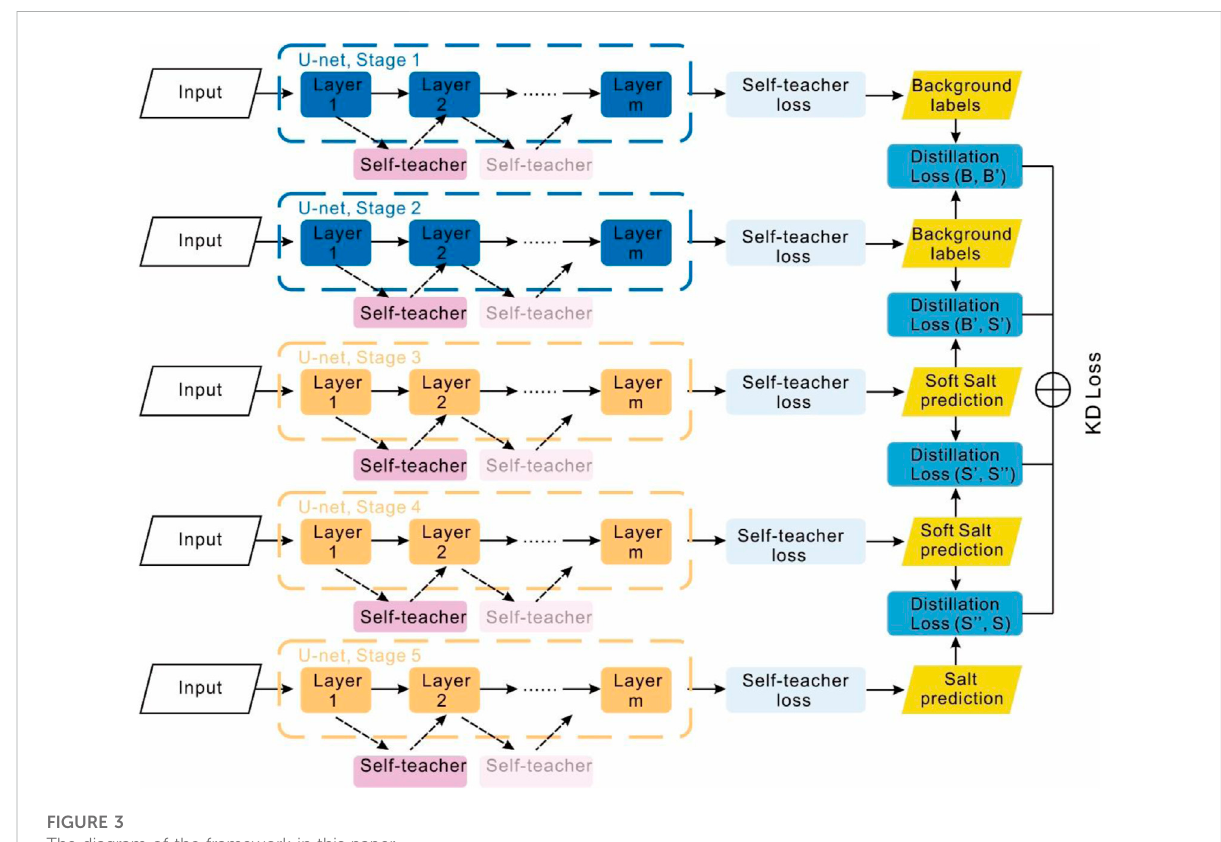
FIGURE 3 The diagram of the framework in this